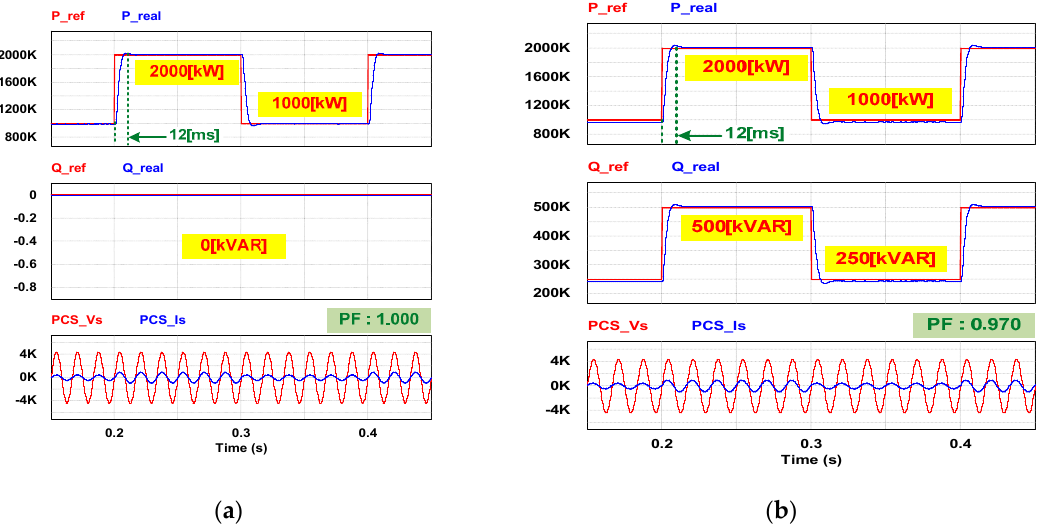
Figure 15. Power controller simulation results: ( a ) active power control, ( b ) active and reactive power control. (Top) Active power response characteristics: Reference value (red line) and real value (blue line). (Middle) Reactive power response characteristics: Reference value (red line) and real value (blue line). (Bottom) Catenary voltage (red line) and PCS current (blue